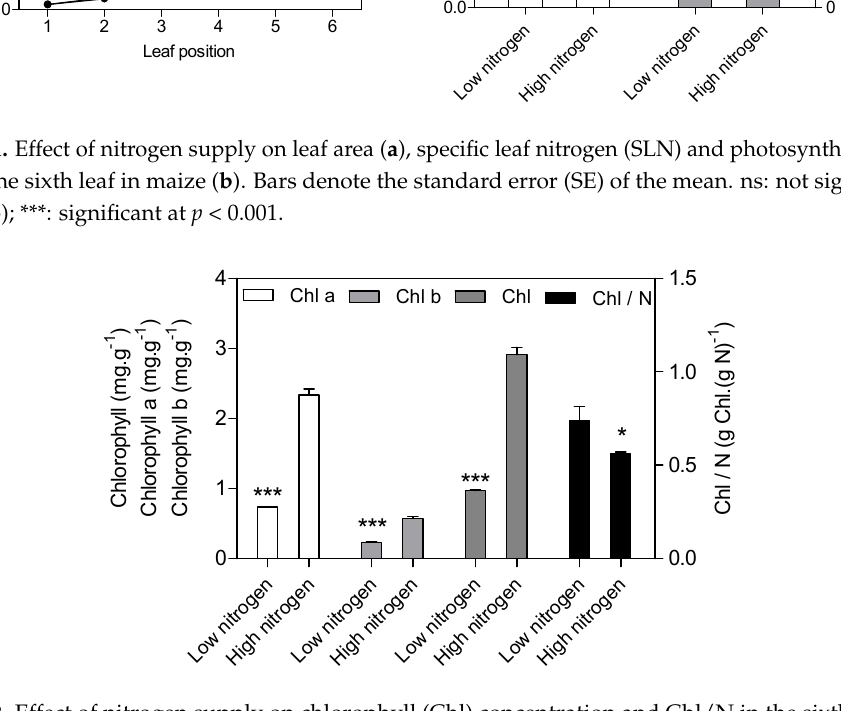
Figure 2. Effect of nitrogen supply on chlorophyll (Chl) concentration and Chl/N in the sixth leaf of maize. High nitrogen: 4 mM Ca(NO 3 ) 2 ; Low nitrogen: 40 µM Ca(NO 3 ) 2 . Bars denote the SE of the mean. ns: not significant ( p > 0.05); *, ** and ***: significant at p < 0.05, 0.01 and 0.001, respectively.